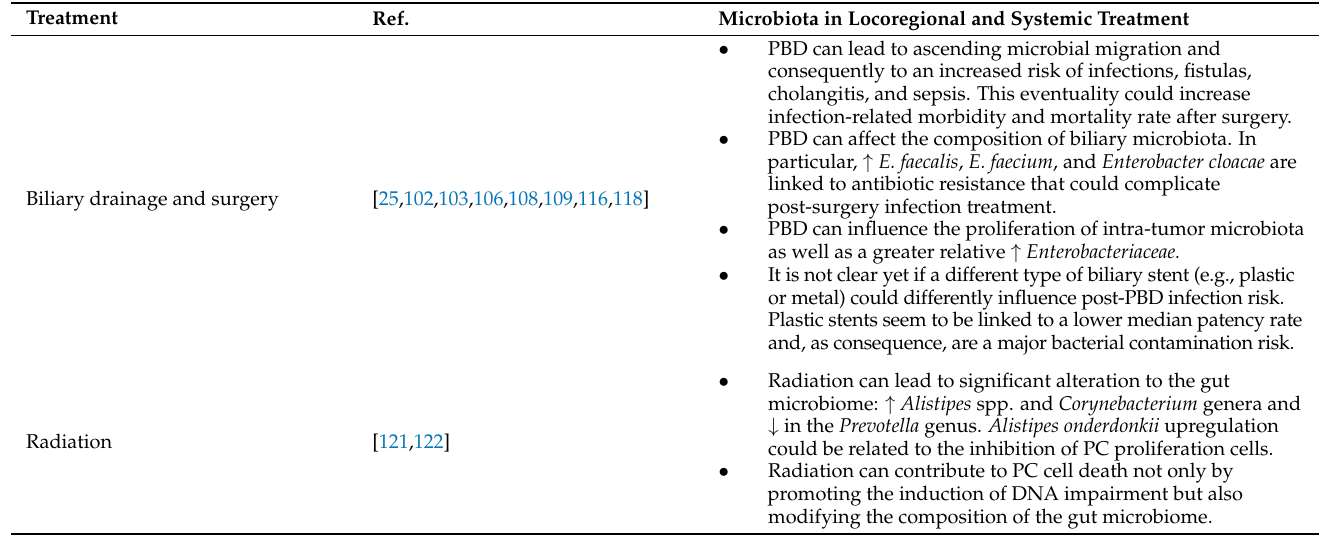
Table 2. Microbiota influence on locoregional and systemic treatment. Treatment